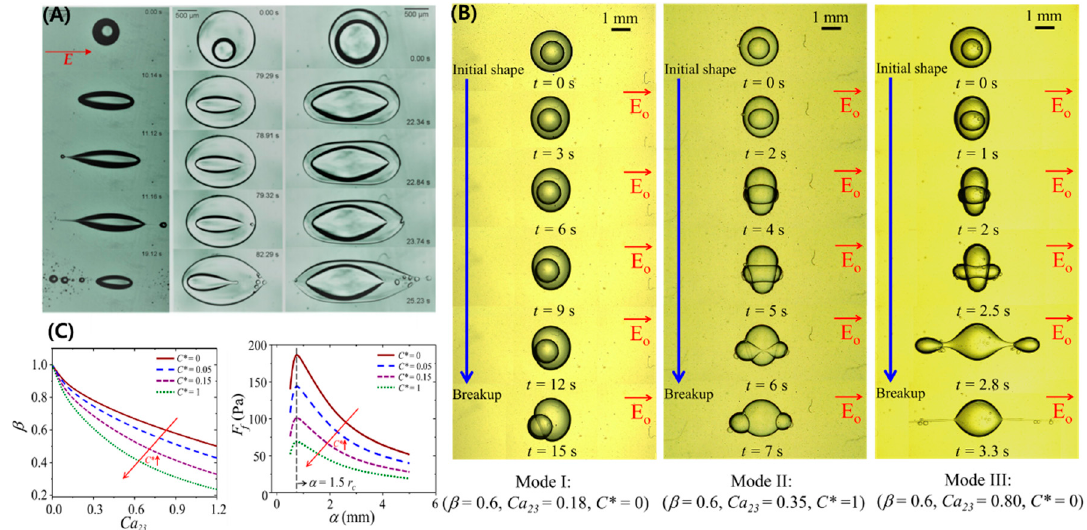
Figure 9. Breakups of a double-emulsion droplet under a strong electric field. ( A ) Emulsion with conducting symmetric core [95] . ( B ) Emulsion with surfactant-laden aqueous core. ( C ) Criterion for core instability and critical electric capillary number for breakups (reproduced from [16] with permission from The Royal Society of Chemistry).